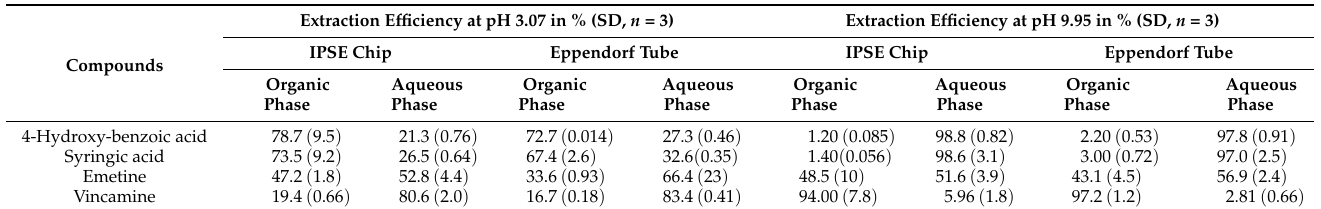
Table 2. Extraction efficiency of four pH-dependent model compounds by IPSE on micro and macroscale.